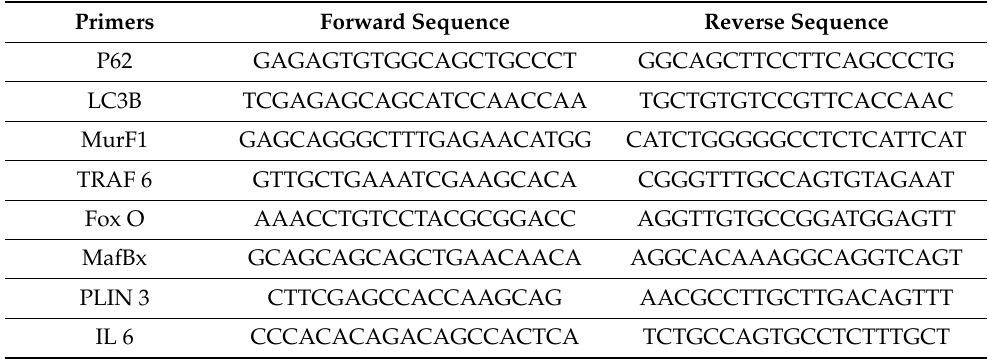
Table A1. Sequences of custom primers used in the study. These primers were designed for differen- tiated human primary